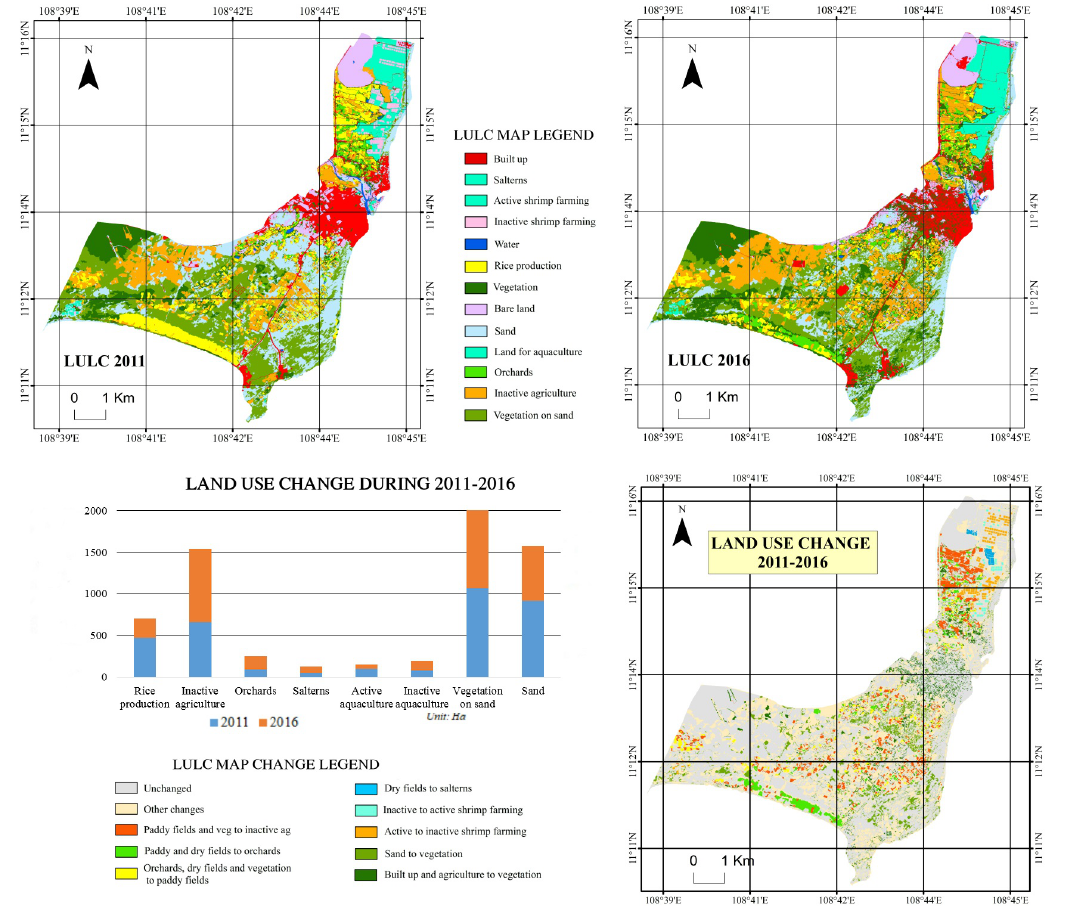
Figure 10. Maps of land use and land cover change during 2011–2016 . Table 5. Changes of specific land types regarding to agriculture and shrimp farming during